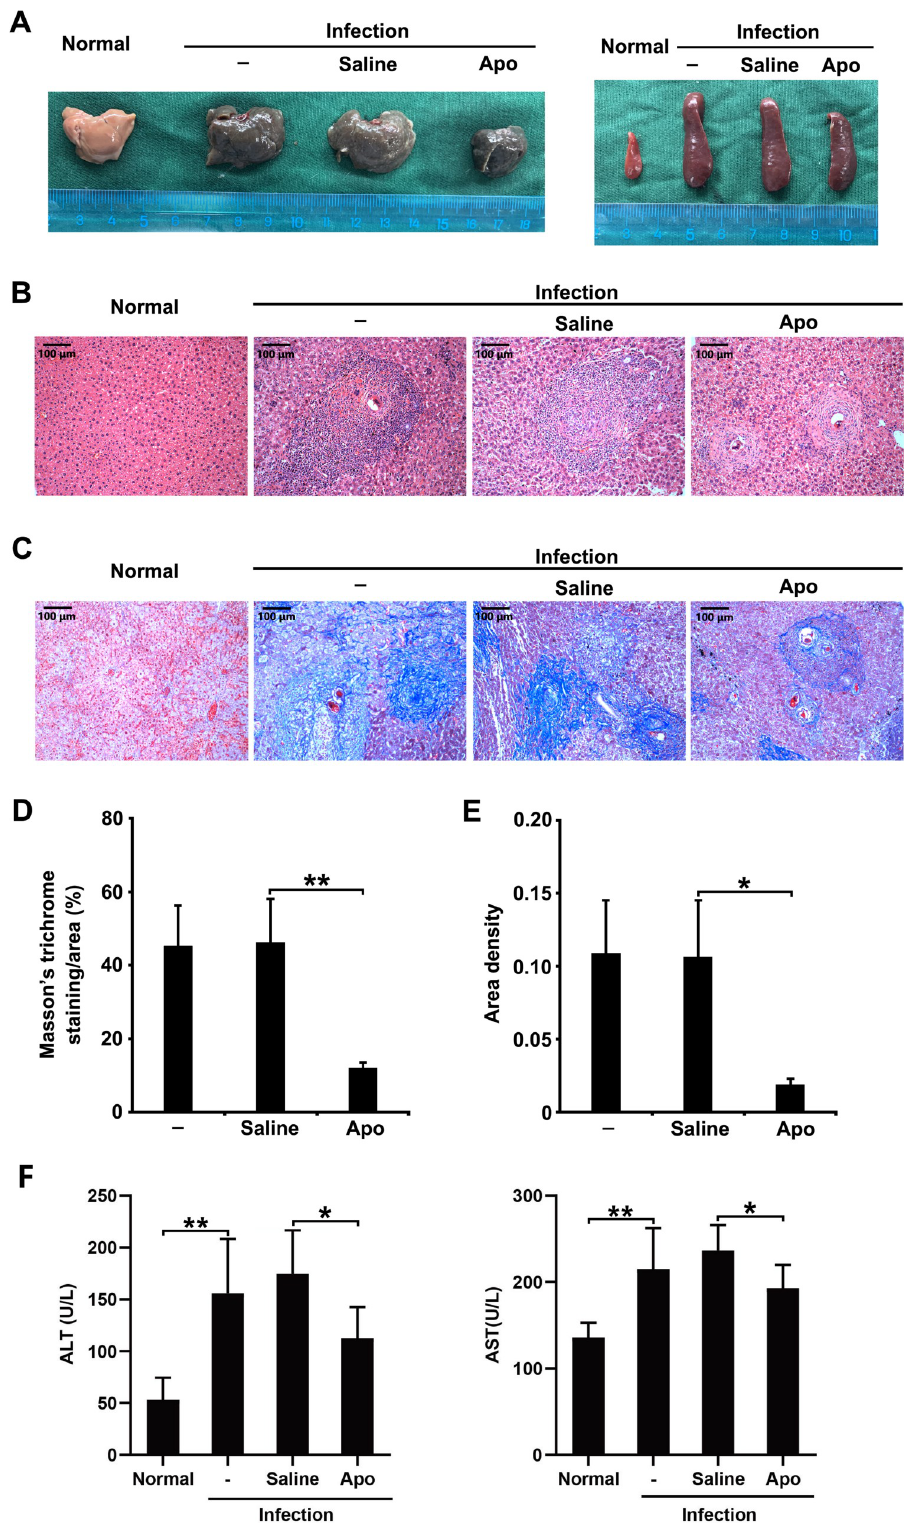
Fig 2. Blocking ROS production reduces hepatic immunopathology in S . japonicum -infected mice. S . japonicum - infected mice were treated with saline or NADPH oxidase inhibitor Apo. (A) Representative images of mouse livers and spleens are shown. Normal, uninfected mice. (B and C) Liver sections were H&E (B) or Masson’s trichrome (C) stained (original magnification, 100-fold; scale bar, 100 μ m). (D and E) Quantification of Masson’s trichrome staining was performed using Image-Pro Plus software and is represented as the percentage of the stained-area per total area PLOS NeglectedTropical Diseases | https://doi.org/10.1371/journal.pntd.0009696 August 16, 2021 7 /